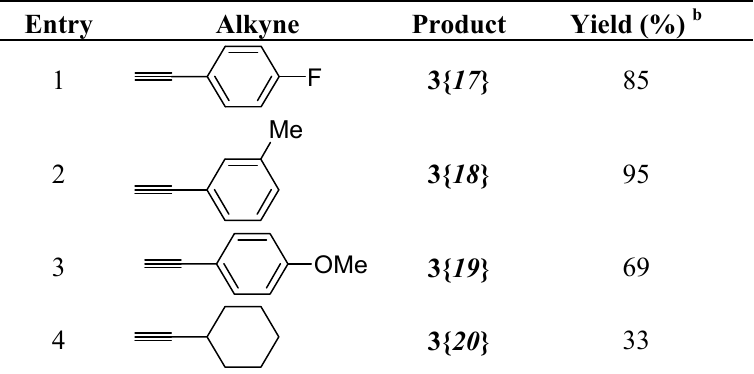
Table 4. Substrate Scope of alkyne in the Reaction with N -benzyl-2-bromobenzamide a .